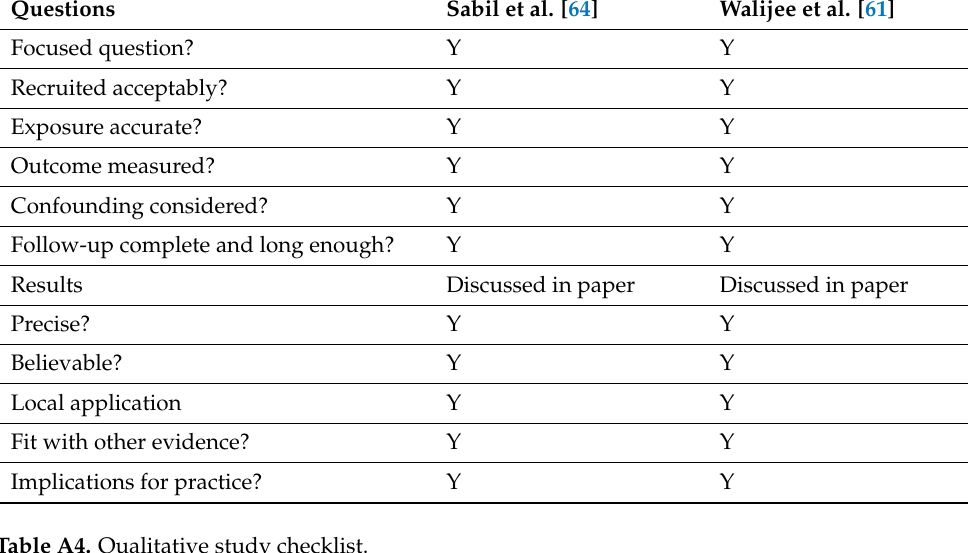
Table A3. Cohort study checklist.